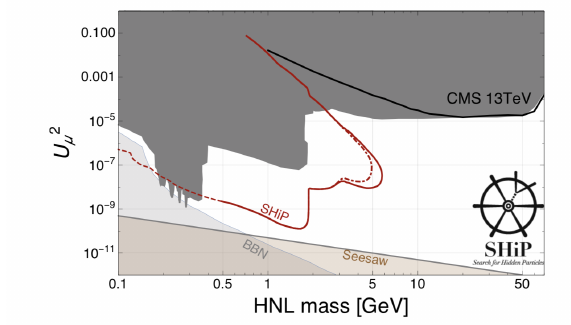
Figure 5. SHiP sensitivity to heavy neutral leptons [9].